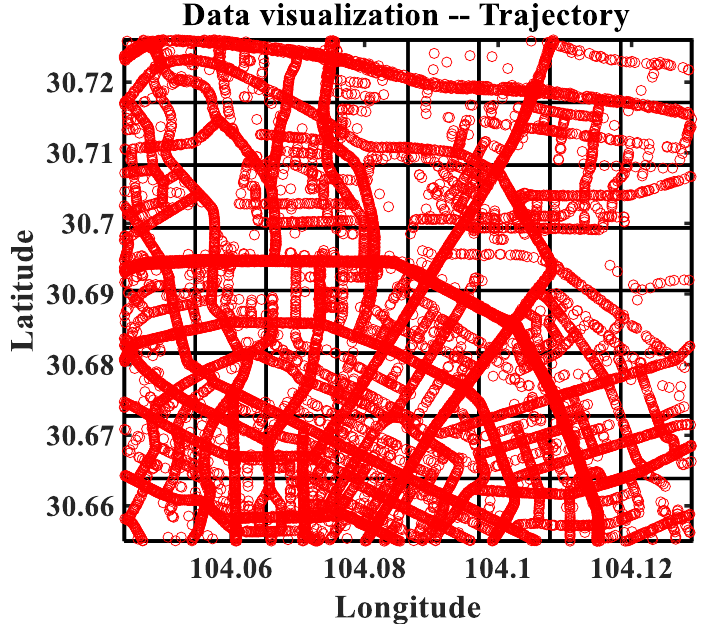
Figure 9. The raw trajectory data of the floating